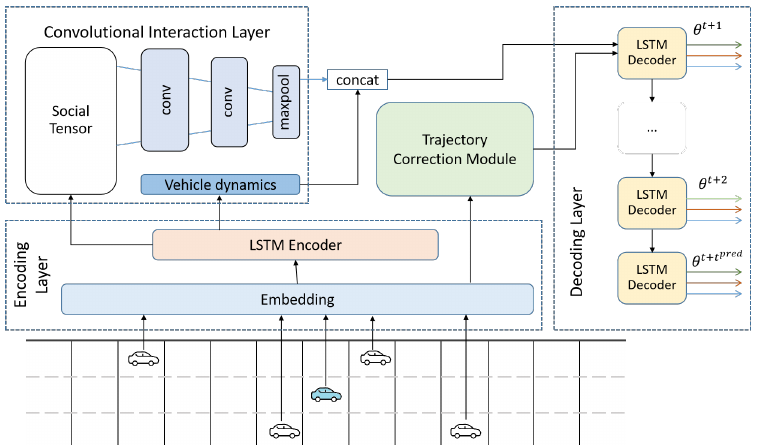
Figure 4. Model Architecture: The LSTM encoders with shared weights generate a vector encoding of each vehicle motion. Convolutional interaction layer models interactions between vehicles. Trajectory correction module corrects predicted vehicle trajectories with probability p during prediction process. Decoding layer receives interaction vector, vehicle coding, and correction information fed into module, and generates distribution of predicted